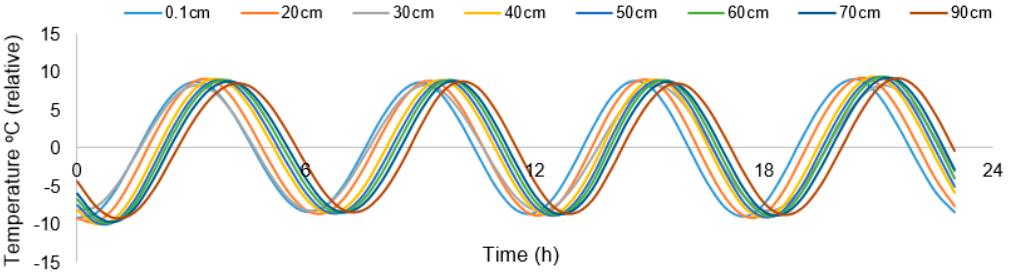
Figure 6. Resampled and filtered temperature time series. A low-pass FIR filter was used to remove high-frequency noise and Dynamic Harmonic Regression (DHR) to remove the long-term trend. Only the changes in amplitude due to artificially induced heating cycles remain.